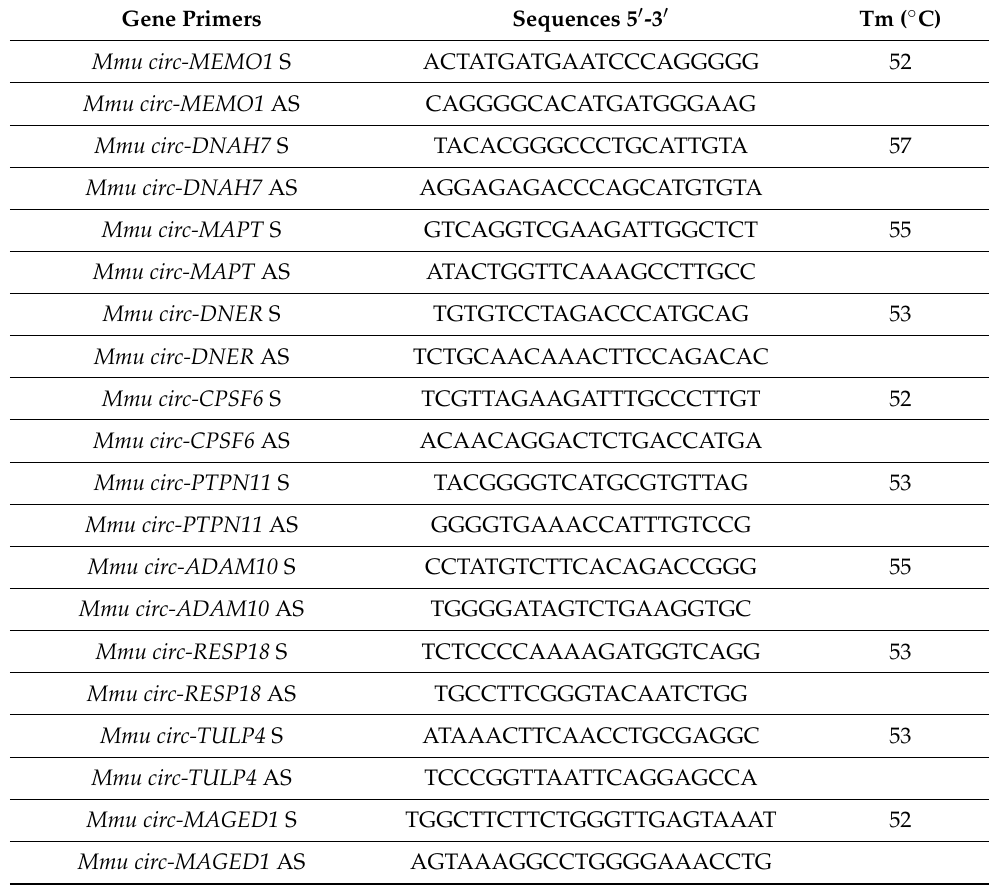
Table 3. Primer sequences and annealing temperatures. Gene